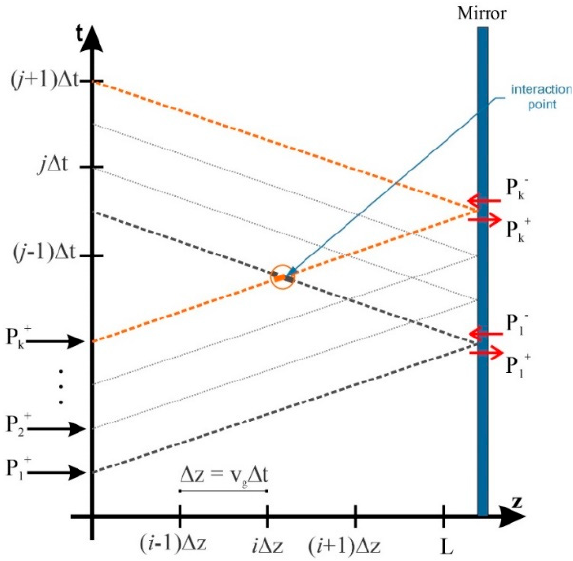
Figure 2. Backward and forward signals in the discrete time–space